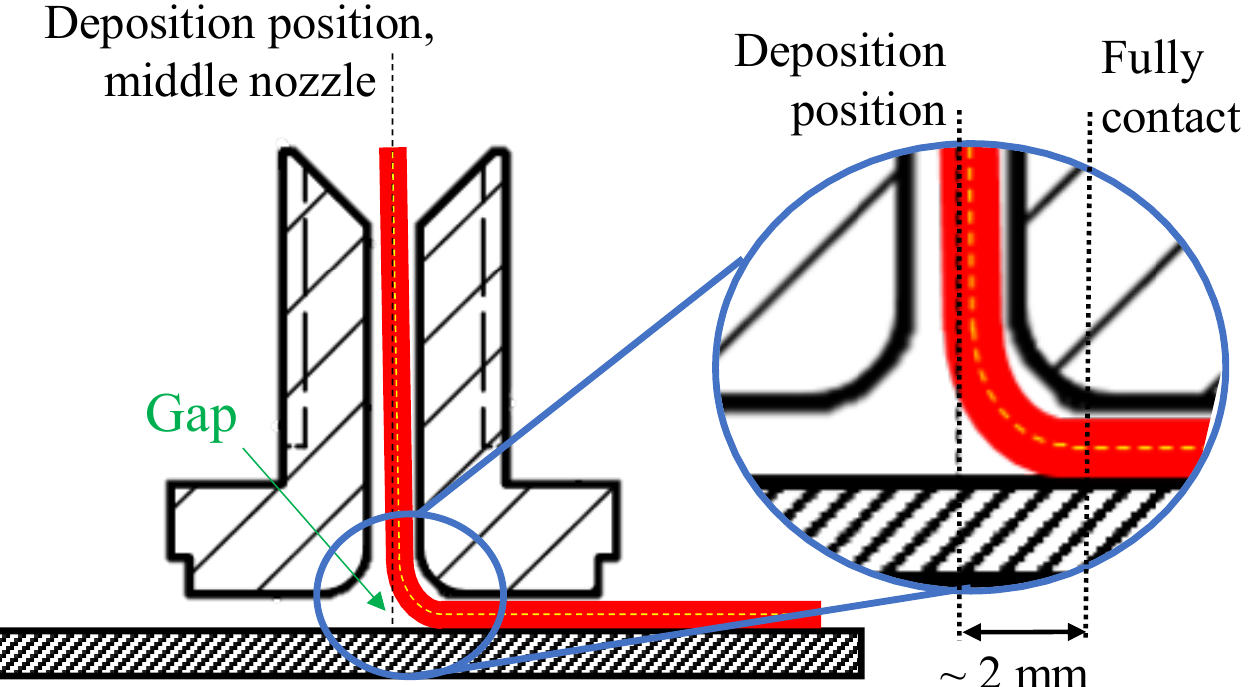
Figure 4. The gap between the filament and the build platform due to the nozzle fillet end creating an offset of the full contact position, and the deviation of filament to the vertical middle line of the nozzle due to the smaller filament diameter than the nozzle diameter.